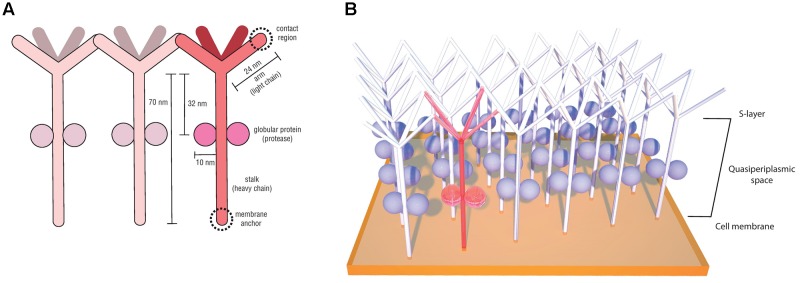
Staphylothermus marinus tetrabrachion structural components (based on the model proposed by Peters et al., 1995) (A) and schematic illustration of its interactions between morphological units on the cell surface (based on the model proposed by Mayr et al., 1996) (B).